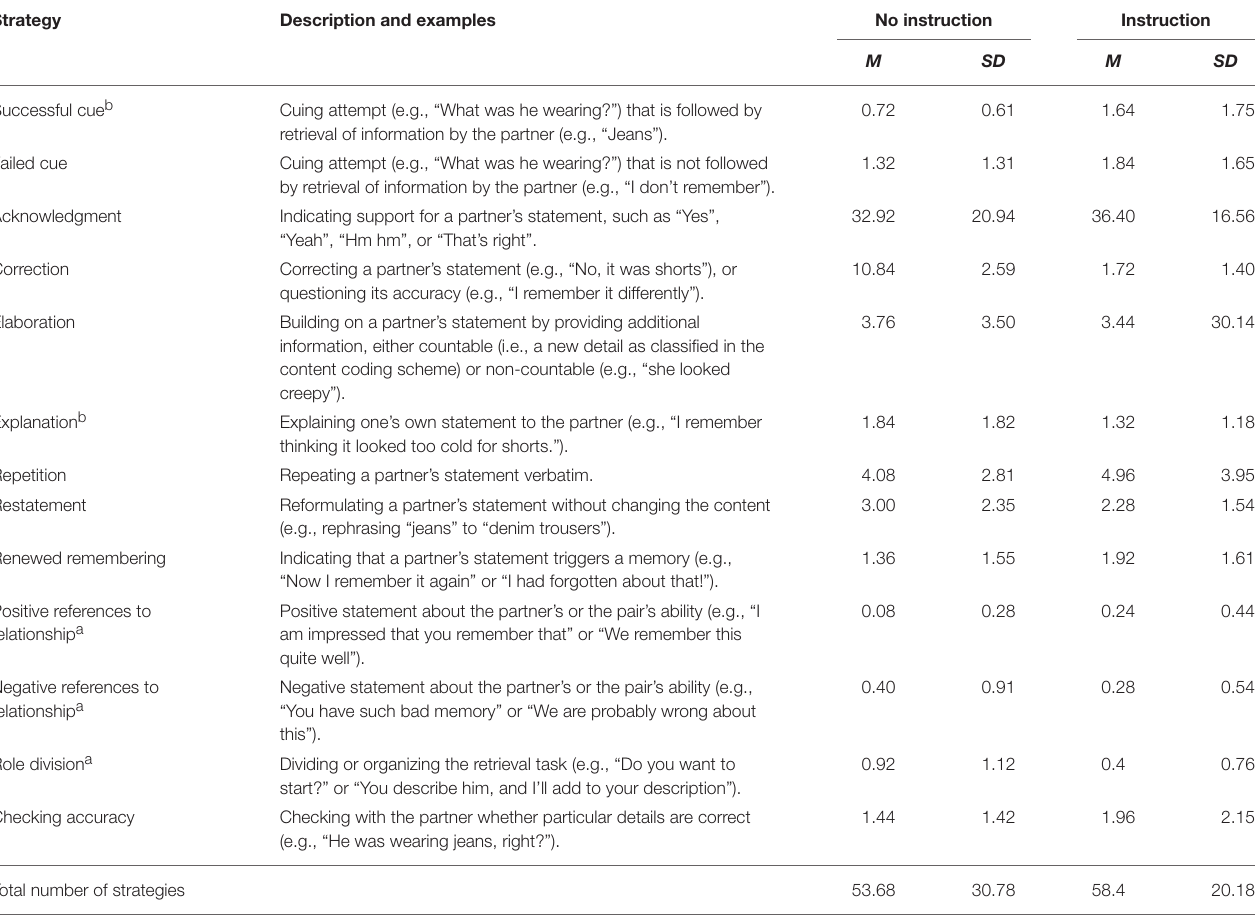
TABLE 1 | Retrieval strategy coding categories with descriptions and examples.